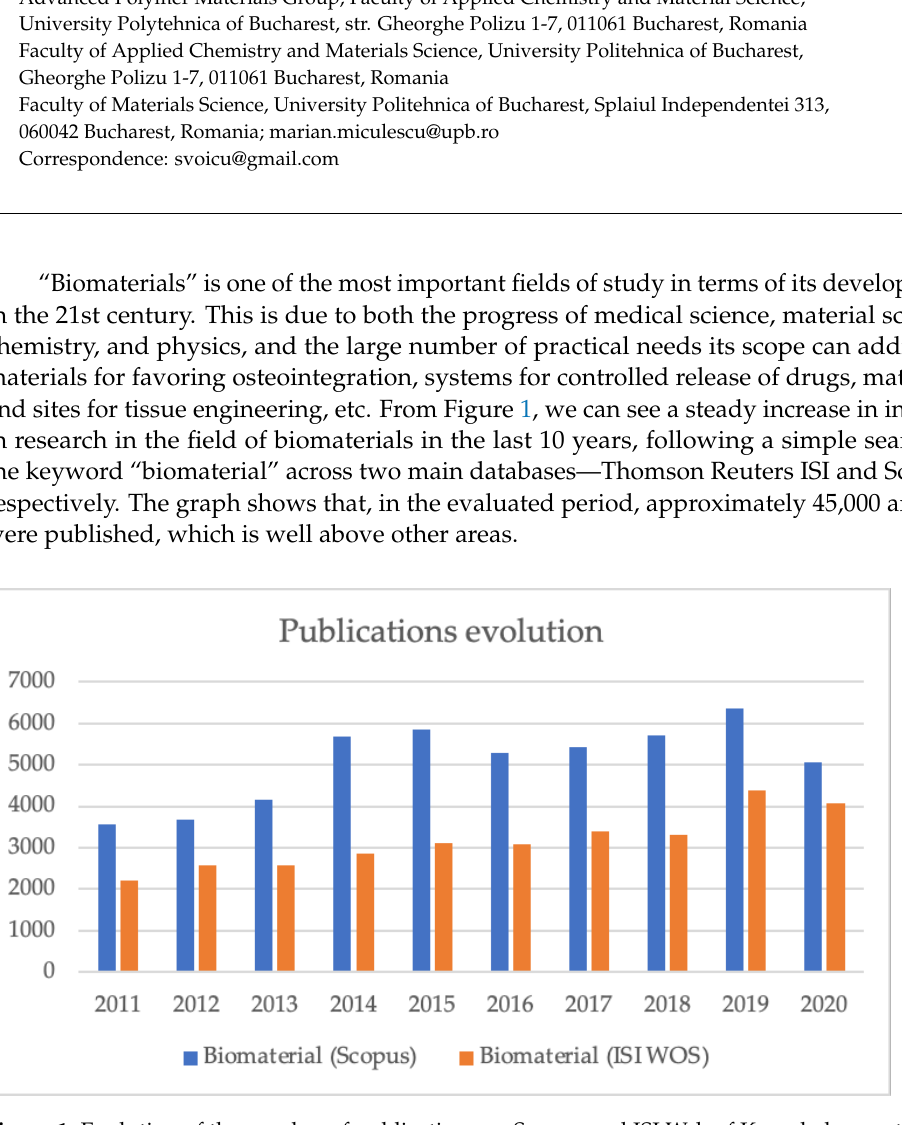
Figure 1. Evolution of the number of publications on Scopus and ISI Web of Knowledge containing “ biomaterial ” during the period 2011 – 2020.